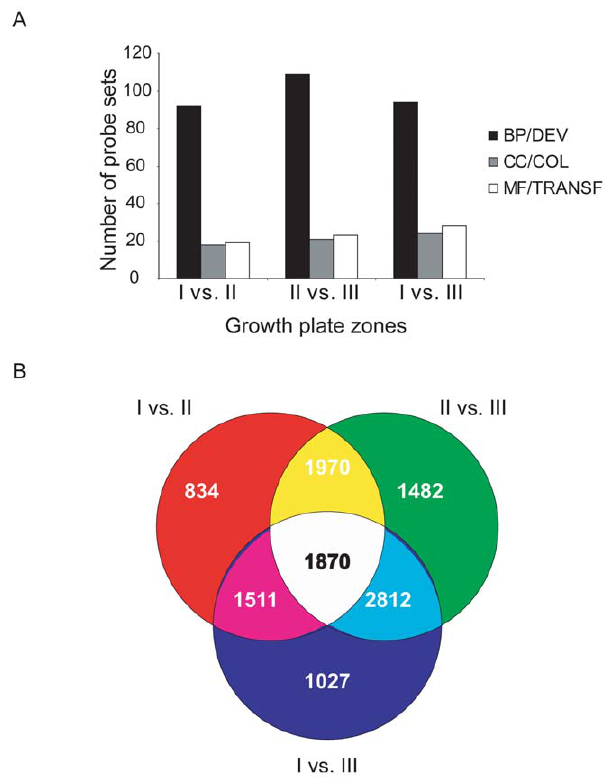
Figure 4. Gene ontology annotations of microdissected growth plate zone comparisons. Lists of probe sets subject to pair-wise comparisons between zones I and zone II (I vs. II), zone II and zone III (II vs. III) and zone I and zone III (I vs. III) were each classified according to biological process (BP), cellular component (CC), and molecular function (MF) (A). The most significant hierarchy was followed in each case until the smallest significant sub-classification was found. In each list, developmental (DEV), collagen (COL) and transporter functions (TRANSF) were identified. P-values less than 0.001 were deemed significant in each case. The number of probe sets both common to each respective zone comparison and unique to a given list was illustrated using a Venn diagram